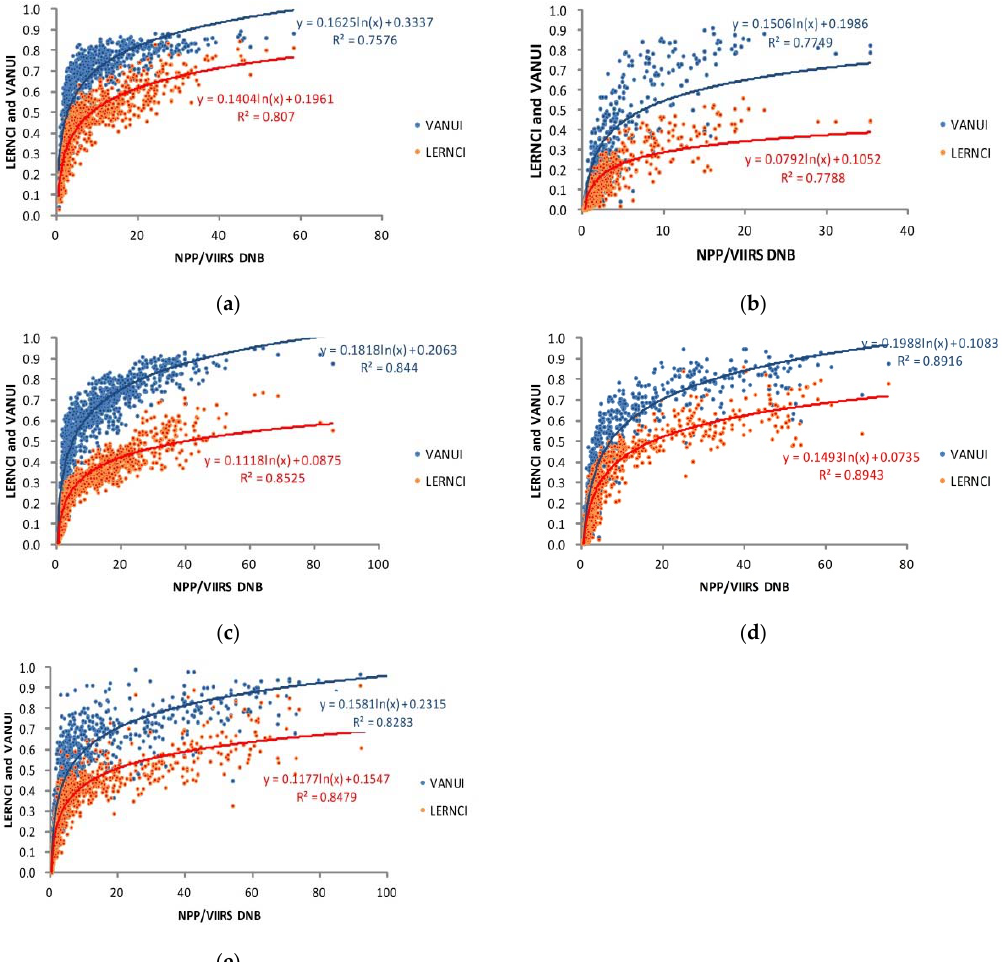
Figure 5. Scatterplot of LERNCI and VANUI against Version 1 Nighttime Visible Infrared Imaging Radiometer Suite Day/Night Band Composite (NPP/VIIRS DNB) of ( a ) Beijing ( b ) Lagos ( c ) Tokyo ( d ) New Delhi ( e ) Seoul. The solid lines correspond to regression line. 4.4 Comparison between LERNCI and VANUI in characterizing population density.